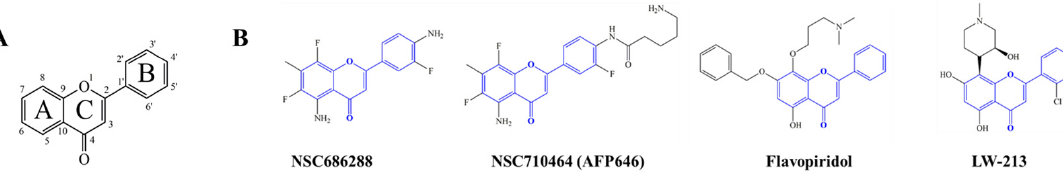
Figure 1. Chemical structures of ( A ) the flavone scaffold with carbon rings denoted A, B, and C and ( B ) of known biologically active amino-functionalized flavones.